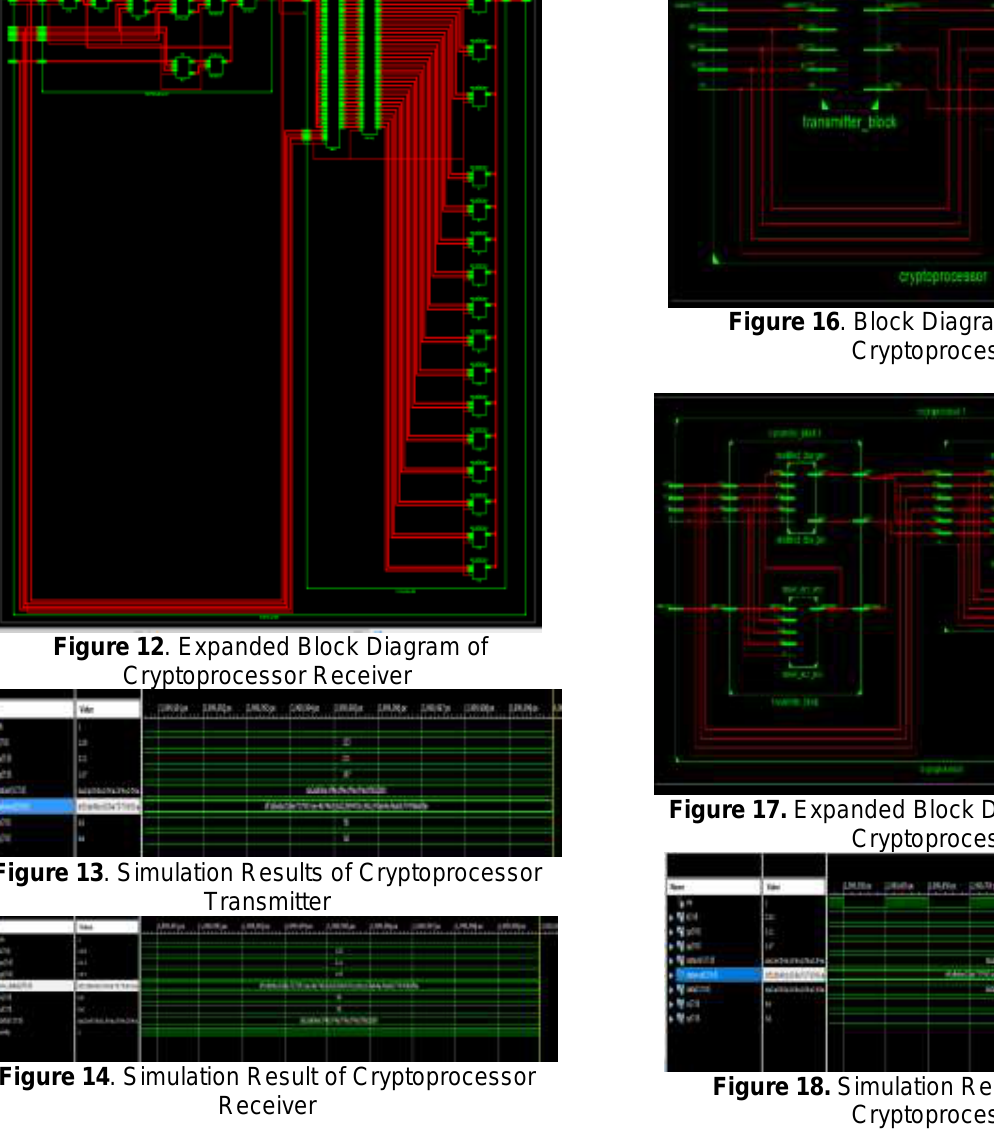
Figure 15 . Top Module of Proposed Cryptoprocessor